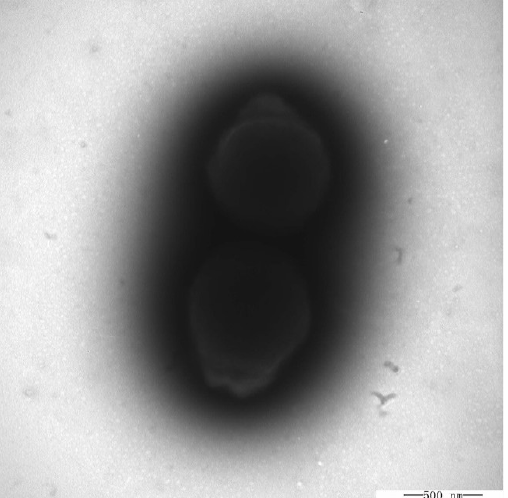
Figure 2. Transmission electron microscope (bar, 500 nm) images of cells of strain OS4 T . Table 1. Differential phenotypic characteristics of strain OS4 T and its related species.